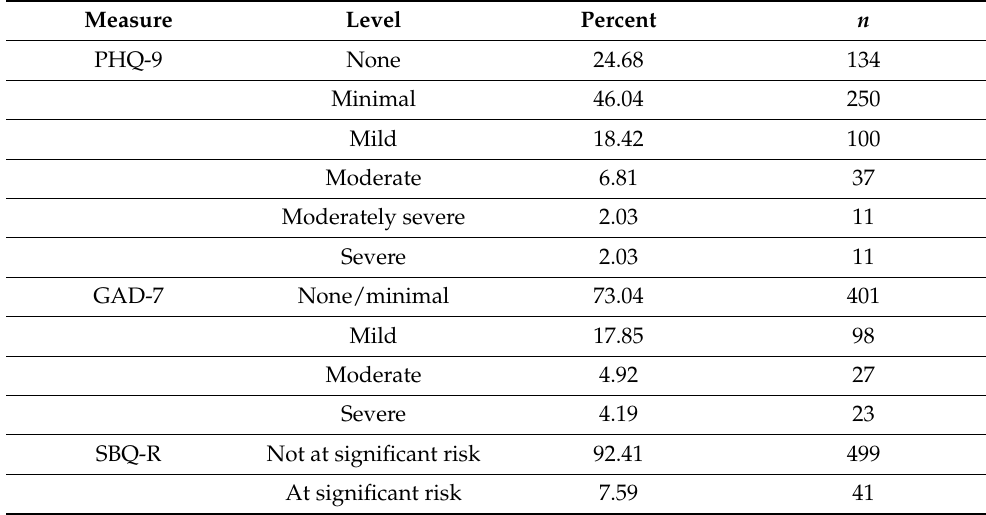
Table 1. Percent and n of respondents by calculated levels of PHQ-9 (depression), GAD-7 (anxiety), and SBQ-R (suicide risk).